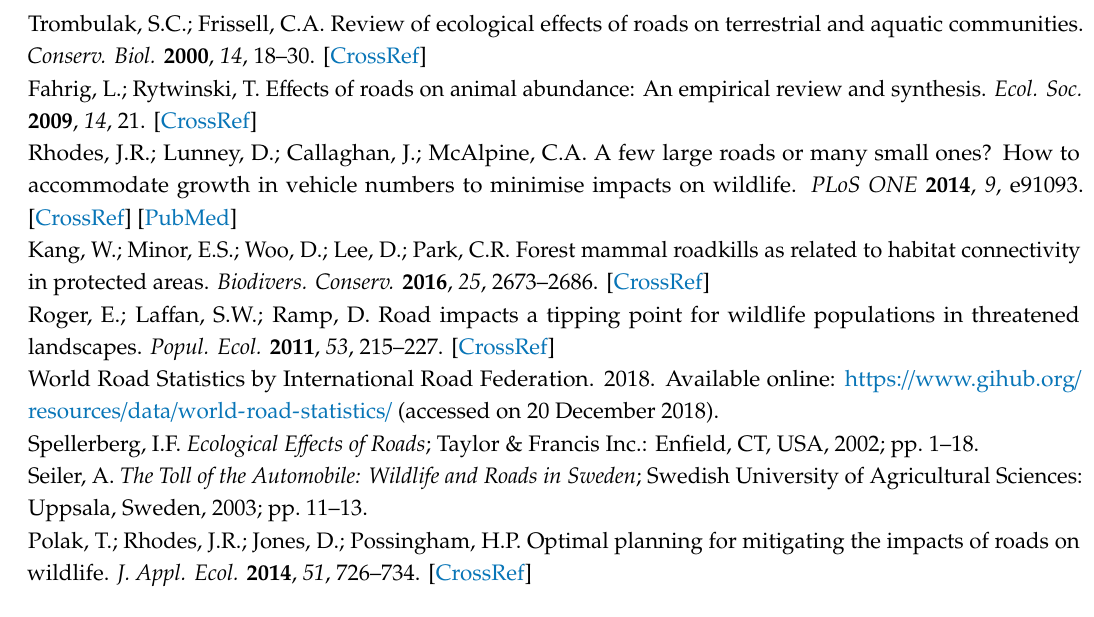
Figure S1: Comparison of standardized (expressed on the scale of 0 to 1) average HSI values calculated for administrative municipalities with standardized moose density values (5-year averages for 2009–2013) calculated for the municipalities, Figure S2: Line histogram comparing the frequencies of distances from MVC and random locations to habitat patches with above-average HSI values, Table S1: Evaluation of the prognostic possibilities of the moose movement model for highway A1, comparing with MVC